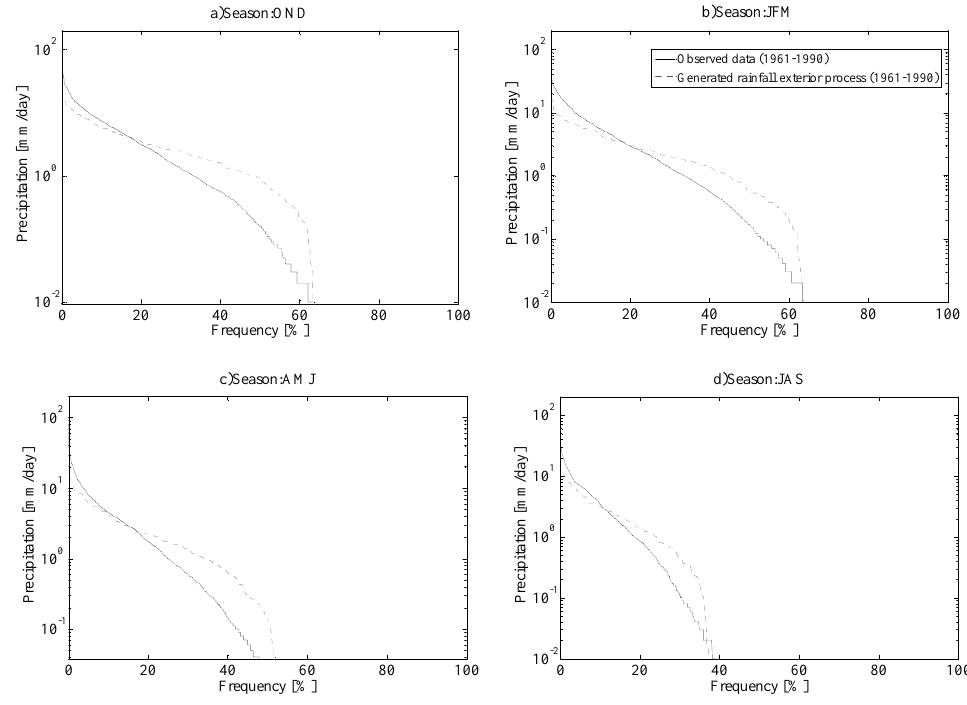
Fig. 7. Duration curves relative to cell #4 for the observed daily rainfall (solid line) and generated rainfall exterior process (dotted line), for the reference period (1961–1990): (a) autumn season; (b) winter season; (c) spring season; (d) summer season.